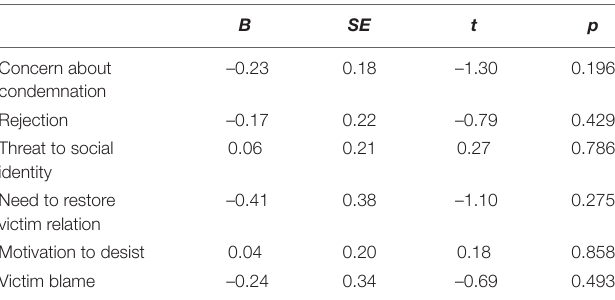
TABLE 6 | Pooled regression coefficients for type of group as predictor, controlled for demographic and case-related variables for the non-significant outcomes ( N =